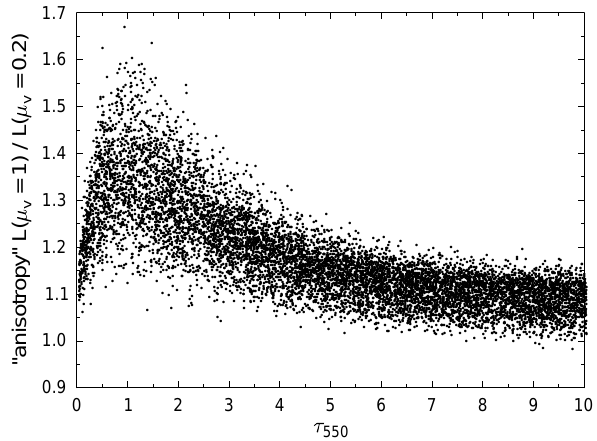
Fig. 5. The “anisotropy”, defined as the ratio of nadir radiance and radiance at 78 ◦ viewing angle, as function of the visible optical thickness.